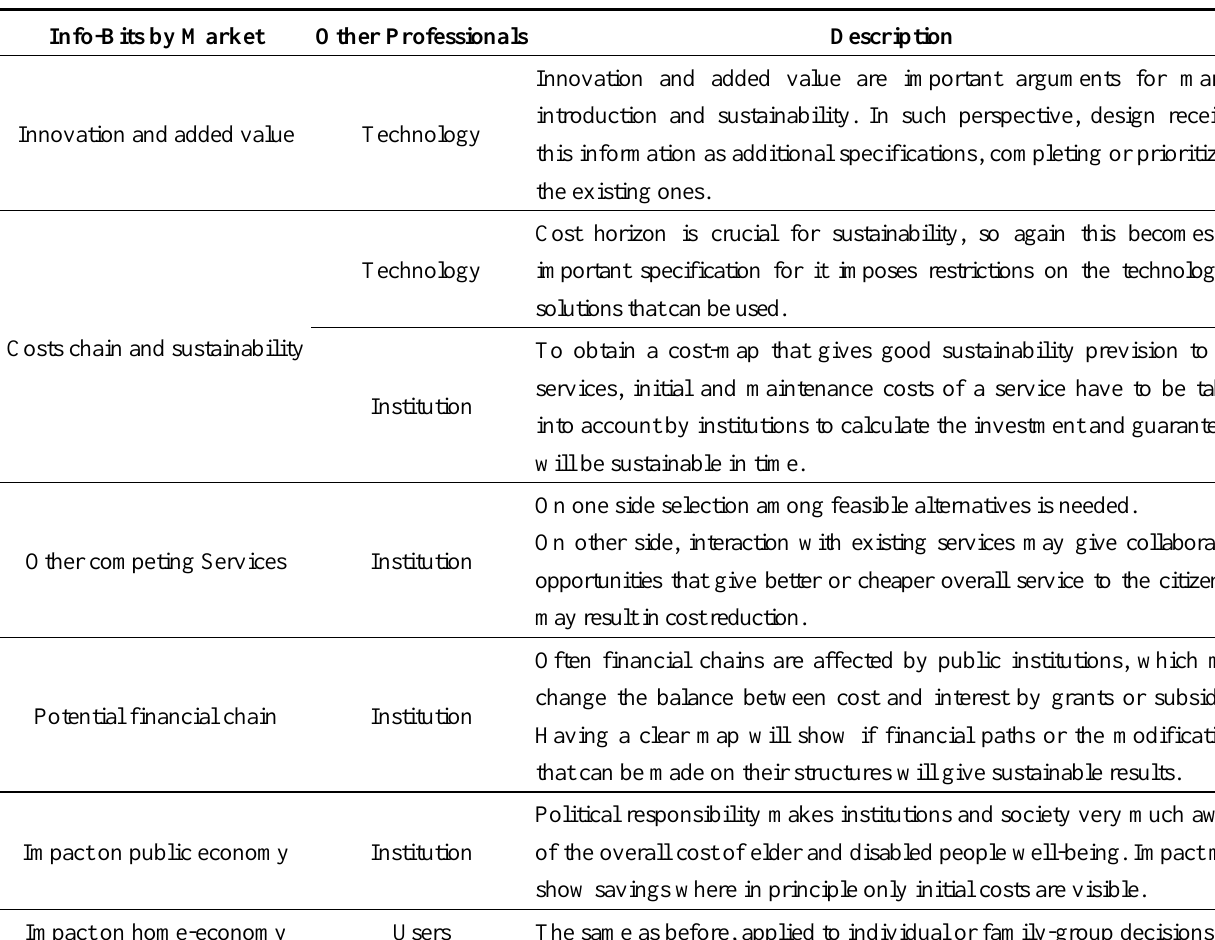
Table 3. Description of importance of information generated by market-oriented professionals as received by other